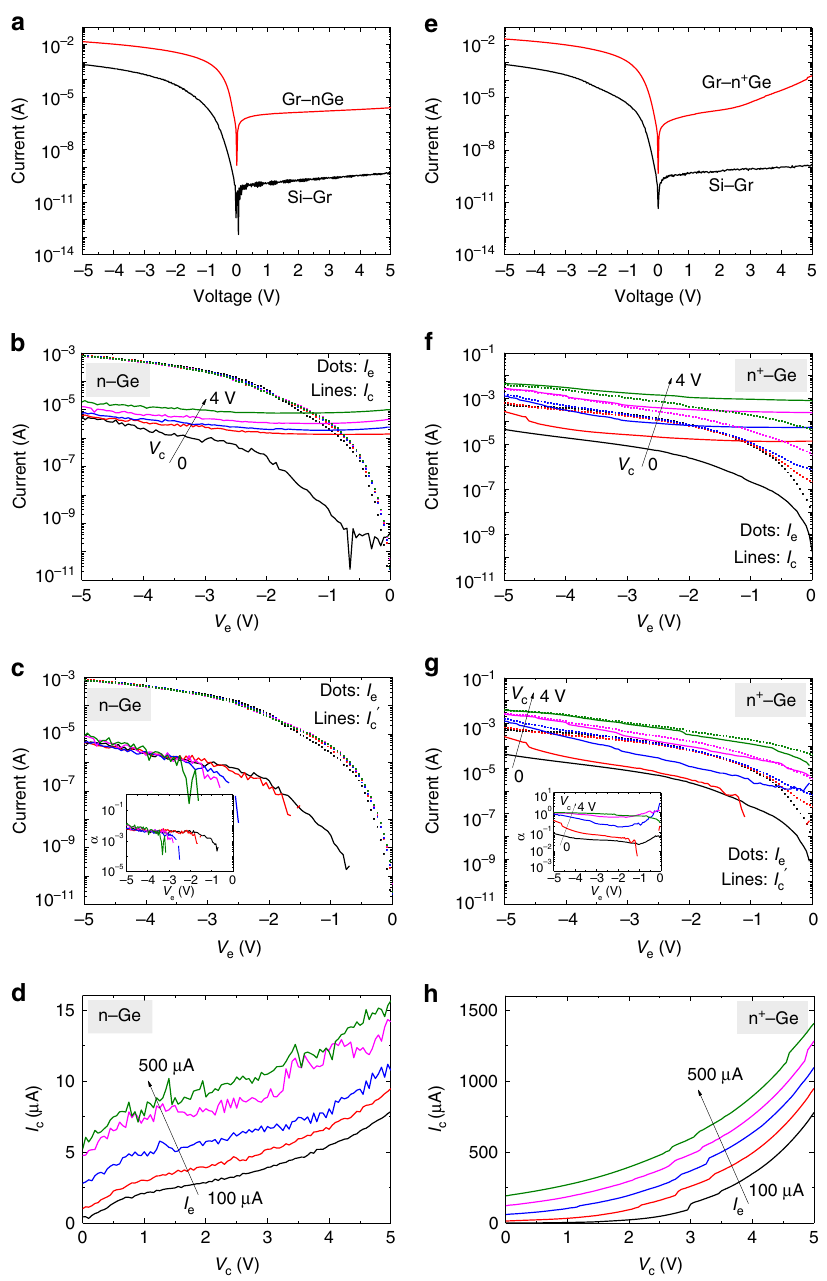
Fig. 3 Electrical characteristics of the Si – Gr – Ge transistors in the common base mode. The fi gures in left column ( a – d ) are for the transistor using a lightly doped n-Ge collector, and those in the right column ( e – h ) are for a heavily-doped n + -Ge collector. a The I – V characteristics of the Si – Gr and Gr-n-Ge junctions. b Input ( I e − V e ) and transfer ( I c − V e ) characteristics where V c changes from 0 to 4 V. c Transfer ( I c 0 (cid:2) V e ) characteristics after eliminating the in fl uence of the collector junction leakage. Inset: common base current gain. d Output ( I c – V c ) characteristics. I e changes from 100 to 500 μ A. e – h Corresponding electrical characteristics of the transistor using a heavily doped n + -Ge